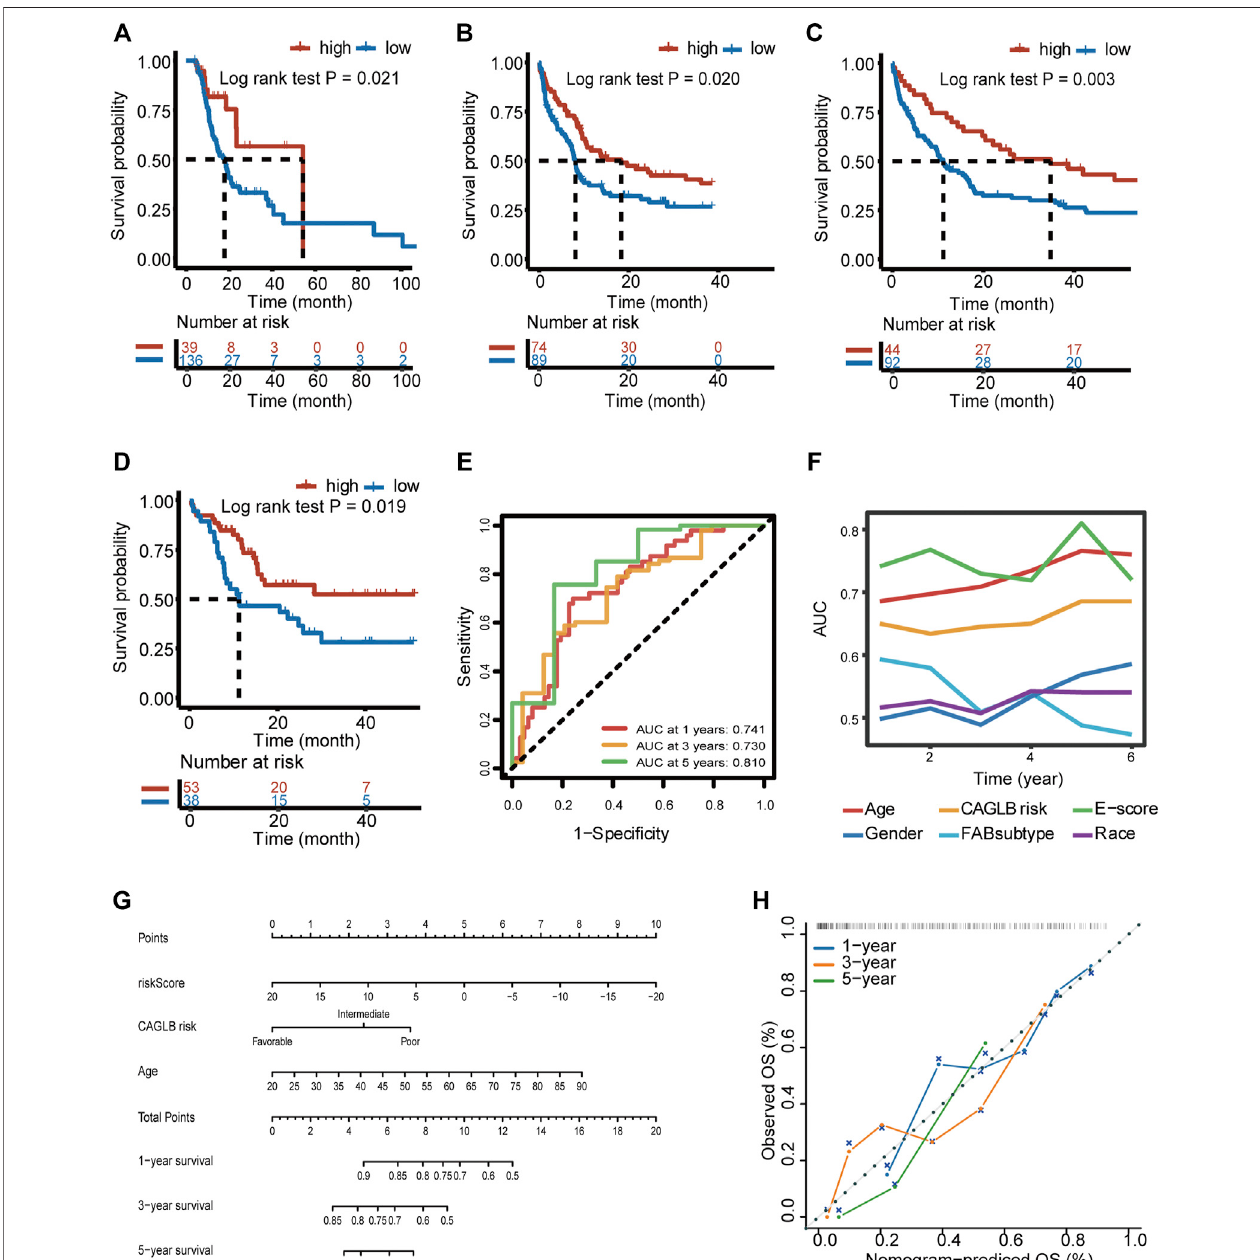
FIGURE 7 | Prognostic power of E-score and a prognostic nomogram established. (A – D) Survival difference between high- and low-E-score groups validated in theBeatAML (A) (log-ranktest p =0.021),GSE37642 (B) (log-ranktest p =0.020),GSE12417 (C) (log-ranktest p =0.003),andGSE10358 (D) (log-ranktest p =0.019) cohort. (E) Predictivepower ofE-score for1-,3-,and 5-yearsurvival, evaluatedbyAUC(0.741 at 1year, 0.730at 3 years, and0.810 at5years). (F) Predictive powerof E-scoreforoverallsurvivalcomparedwithotherclinicalcharacteristics,evaluatedbyAUC. (G) Thenomogram constructedbyintegratingE-scoreandotherclinical features. (H) Calibration curves of our nomogram on the estimation of 1-, 3-, and 5-year overall survival.